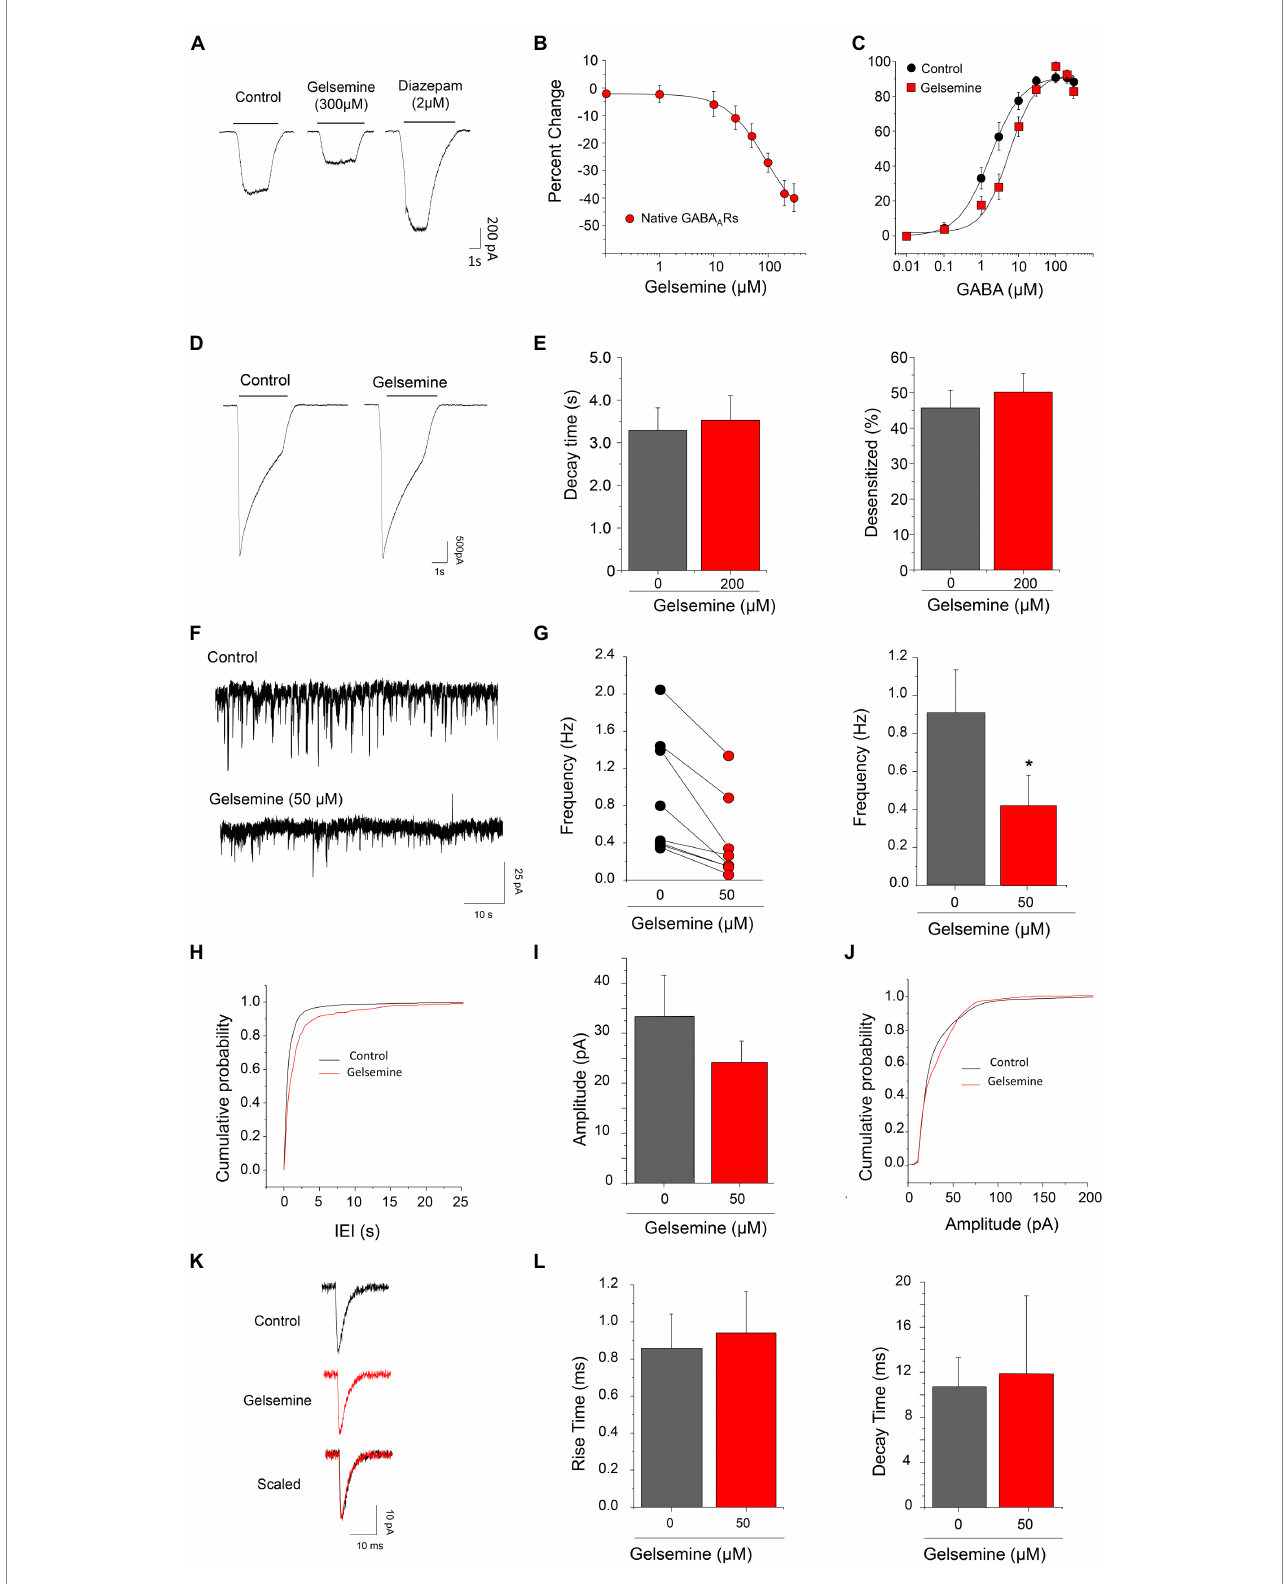
FIGURE 2 Gelsemine modulation of native GABA A Rs and of GABAergic neurotransmission. (A) Representative traces showing the inhibitory effects of gelsemine (300 μ M) and the positive effects of diazepam (2 μ M) on GABA-evoked currents (0.5–1 μ M) through native GABA A Rs. (B) The graph summarizes the gelsemine effects (0.1–300 μ M) on the GABA-evoked currents. Data are means ± SEM of 8 neurons. (C) GABA concentration-response curves in the absence (black circles) and presence (red squares) of gelsemine (200 μ M). Data are means ± SEM of 12 cells per condition. The GABA sensitivity was significantly altered by the alkaloid (Table 1). (D) Representative current traces from native GABA A Rs using a saturating concentration of GABA (300 μ M) in the absence